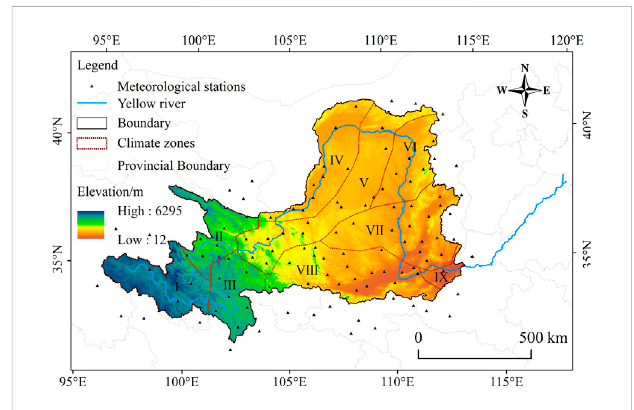
FIGURE 1 Map of the upper and middle reaches of the Yellow River Basin (I: Qingnan District; II: Qilian – Qinghai Lake District; III: Bomi – Chuanxi District; IV: Middle Temperate Zone Menggan District; V: Middle Temperate Zone Mengzhong District; VI: Middle Temperate Zone Mengdong District; VII: South Temperate Zone Jin – Shaanxi – Gan District; VIII: South Temperate Zone Weihe District; IX: South Temperate Zone Luhuai